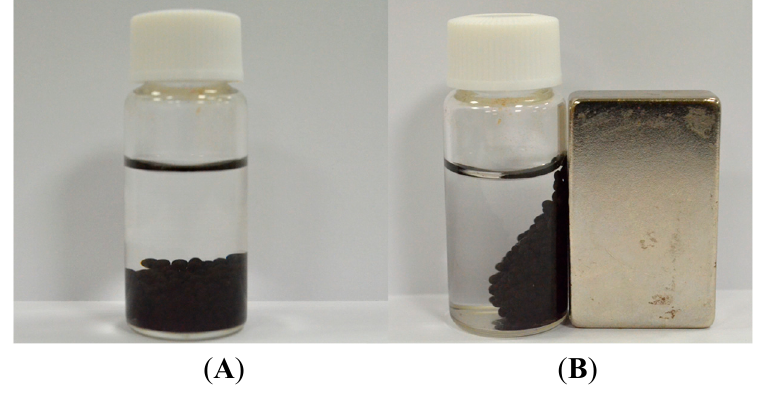
Figure 6. The synthesized MIO entrapped alginate beads were attracted by a magnet, indicating their superparamagnetic characteristics. ( A ) The MIO entrapped alginate beads distributed in suspension ( B ) The MIO entrapped alginate beads could be very easily and efficiently separated from the suspension using a